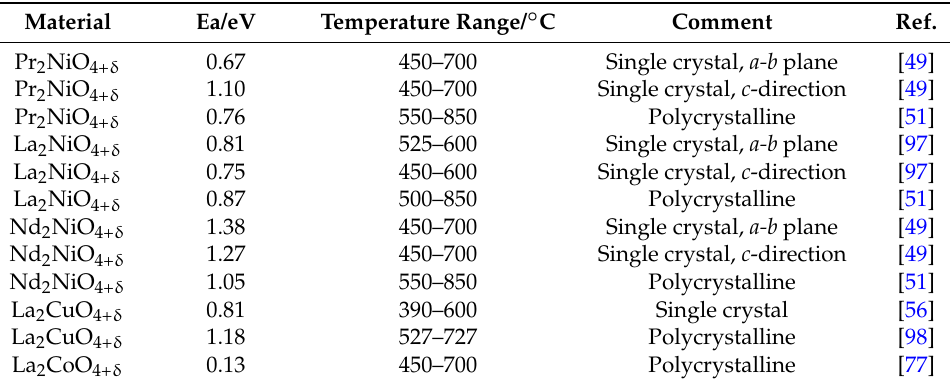
Table 3. Activation energies of oxygen self-diffusion in A 2 BO 4+ δ